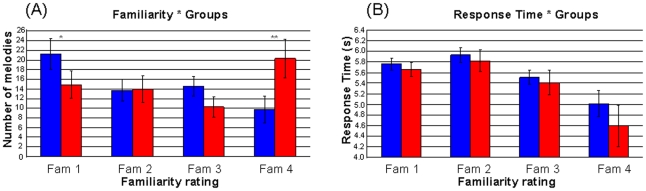
Behavioral results.Interaction effects between (A) familiarity ratings (responses numbers) and groups (musicians and nonmusicians), and (B) response time (in seconds) and groups (musicians and nonmusicians). Significant differences at p < .05 (*) and p < .001 (**).